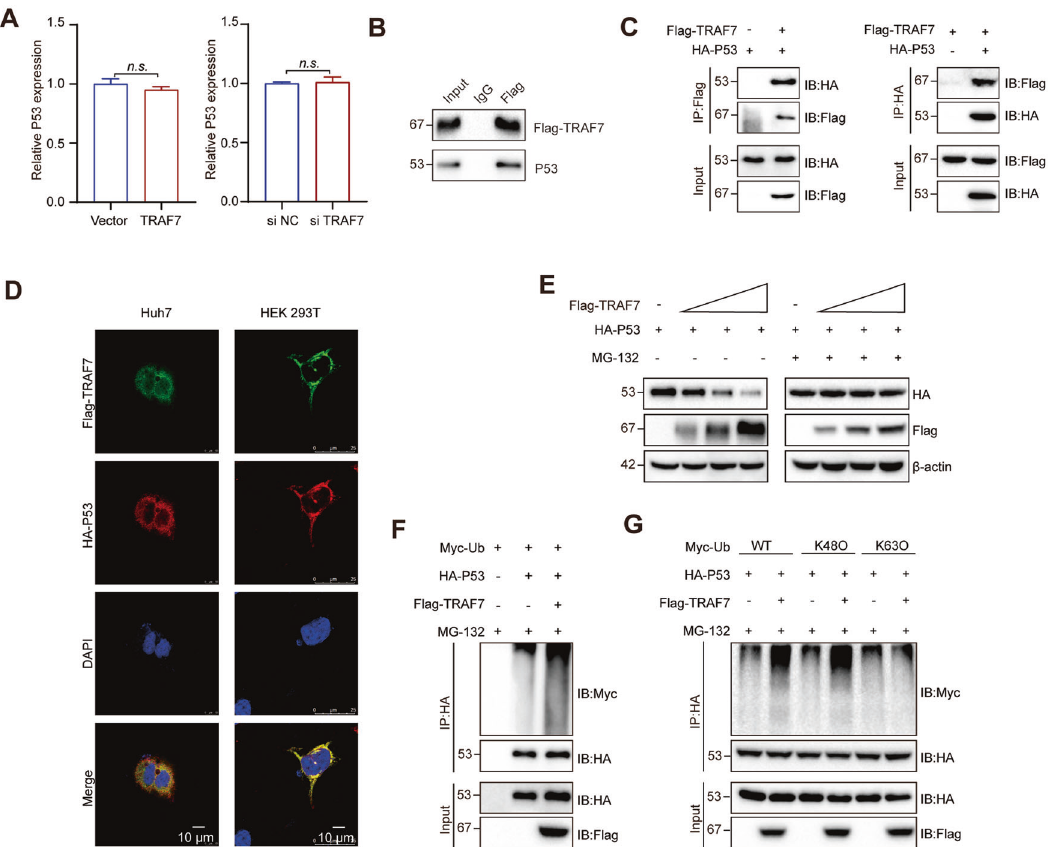
Fig. 4 TRAF7 promoted K48-linked ubiquitination and degradation of P53. A the expression of P53 mRNA when TRAF7 modulated in HCC cells. B Endogenous co-IP assay showed that P53 was present in Flag immunocomplex, however absent in the IgG immunocomplex. C Exogenous co-IP assays were conducted to identify the interaction of TRAF7 and P53. D Immuno fl uorescence analysis showed TRAF7 and P53 co-located after co-transfected with Flag-TRAF7 and Ha-P53 in HEK-293T and Huh-7 cells. E P53 protein level after TRAF7 gradient transfected in Huh-7 cells with or without MG132. F Western blotting analysis of the ubiquitination of P53 in Huh-7 cells transfected with TRAF7 plasmid. MG132 was added for 6 h before harvest. G Ubiquitination screening of P53 by TRAF7 with indicated types of ubiquitin (K48O and K63O). ** p < 0.01; *** p <